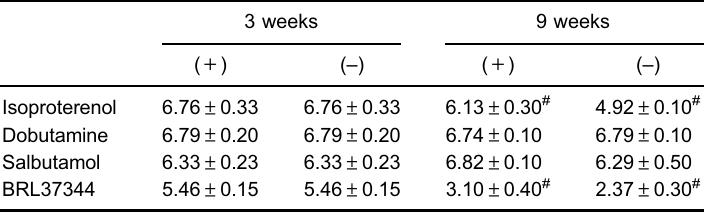
Data are reported as means ± SD. # P o 0.05, compared to 3-week-old rats (ANOVA followed by Newman Keuls